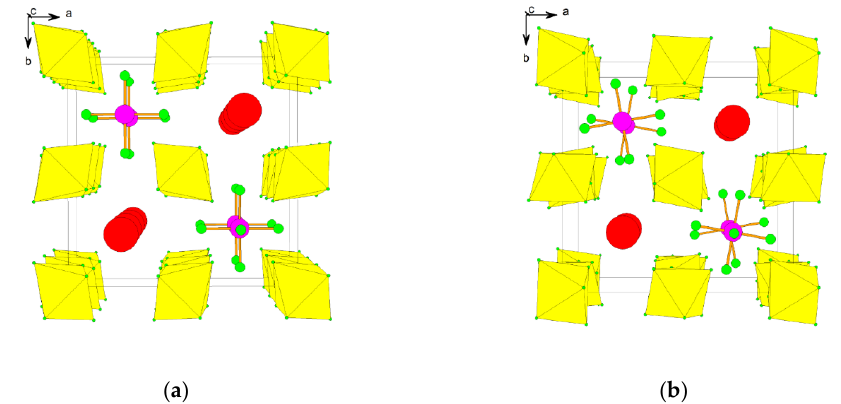
Figure 12. ( a ) Packing of Rb + and [XeF 5 ] + cations and [SbF 6 ] − anions in the crystal structure of high-temperature (296 K) form of β -Rb[XeF 5 ][SbF 6 ] 2 ; ( b ) Packing of Rb + and [XeF 5 ] + cations and [SbF 6 ] −